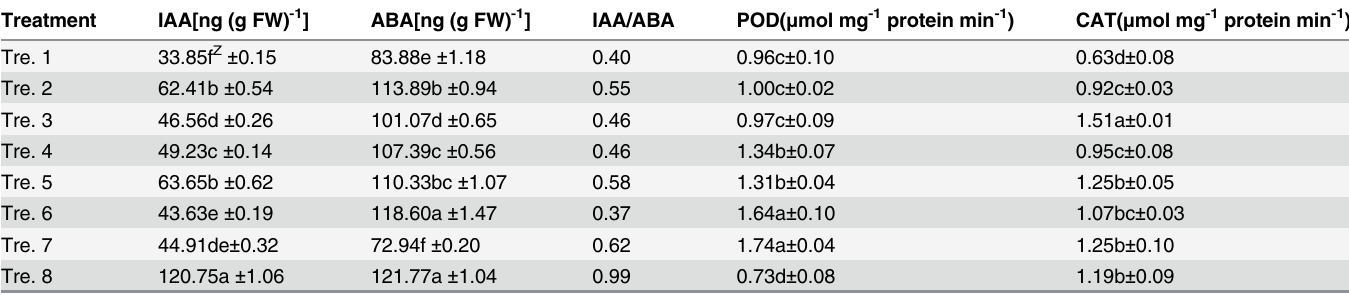
Table 8. Biochemical observation for the underground renewal buds during ‘ Hangbaishao ’ bud dormancy.